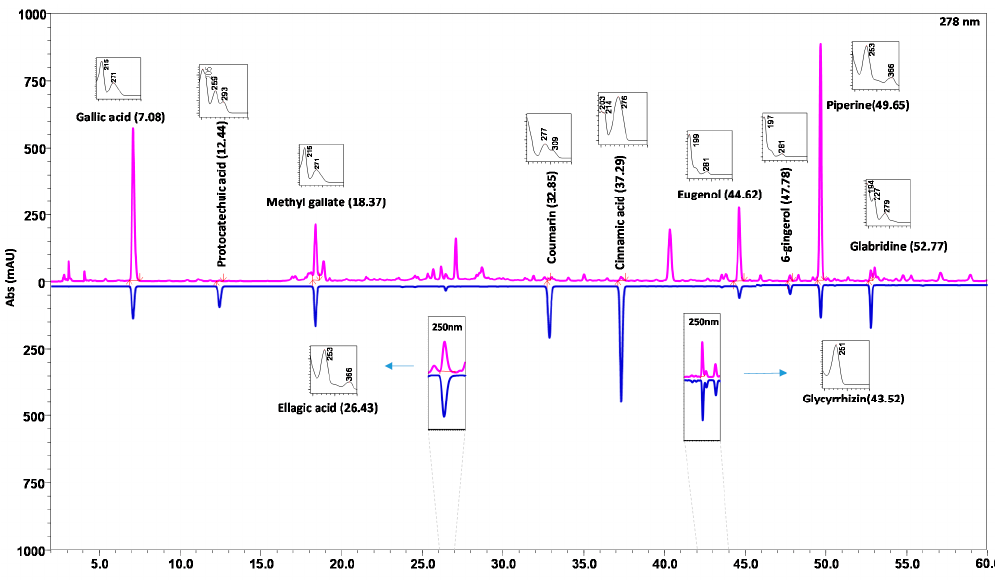
Figure 2. HPLC–DAD analysis identified and quantified the presence of 11 targeted marker components in DSV. The DSV sample (pink lines) was compared using reference standard mix (blue lines). The chromatograms were recorded at 278 nm for (methyl gallate, coumarin, cinnamic acid, eugenol, 6-gingerol, piperine and glabridin), and at 250 nm for ellagic acid and glycyrrhizin. UV-spectra of each detected analyte has been shown in the respective insets, along with HPLC retention times.